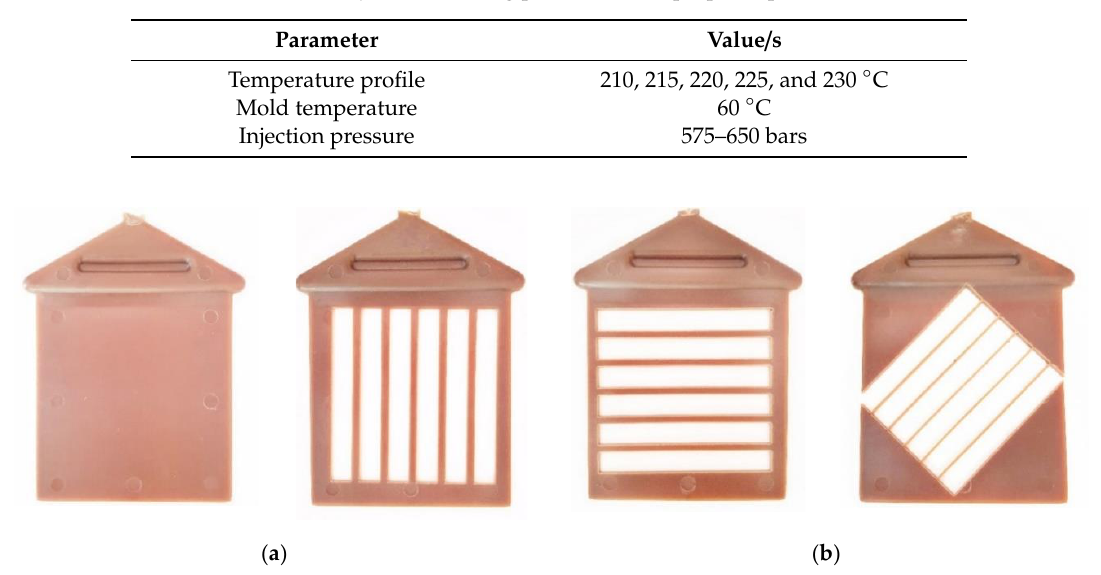
Table 1. Injection molding parameters for pulp composites.